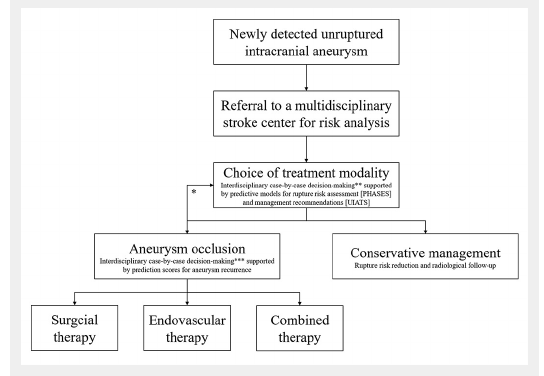
Proposed algorithm for the management of unruptured intracranial